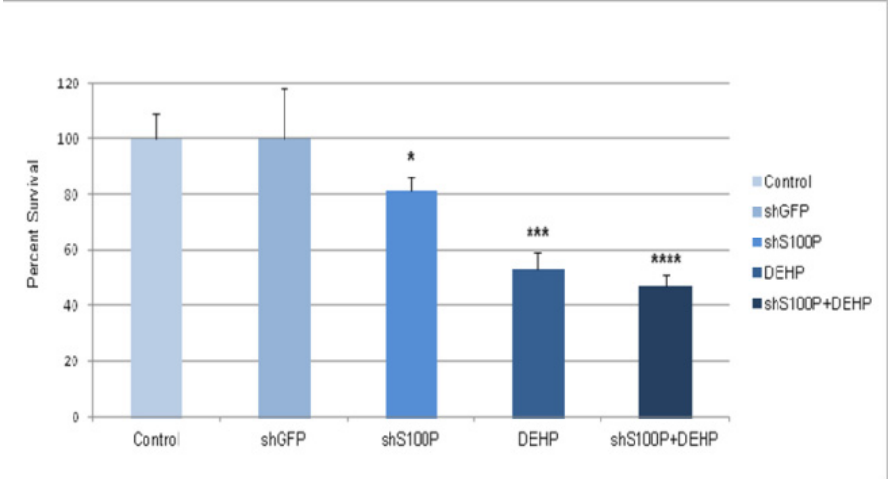
Figure 2. MTS assay of LN-229 cells after 48 h exposure to DEHP alone and in combination with S100P knockdown. The data is presented as mean ± SEM of experiments performed in